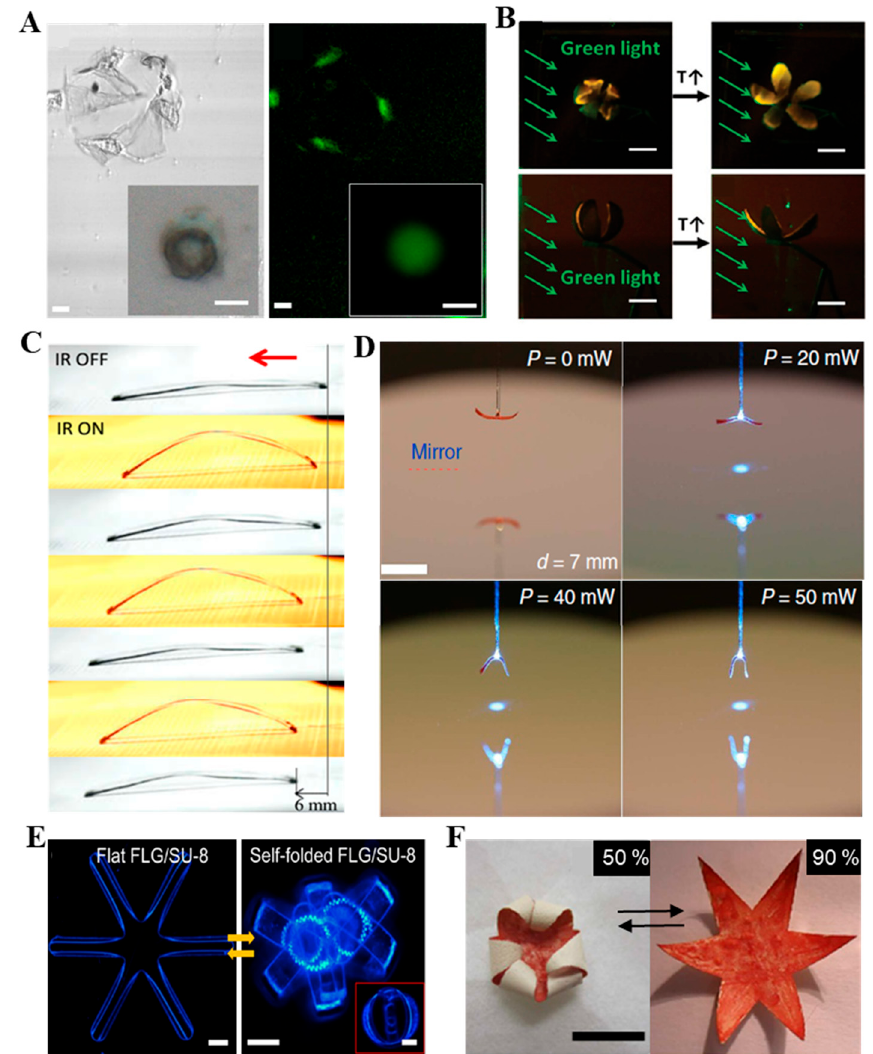
Figure 5. ( A ) Encapsulation of live cells within the functionalized flower-shaped thermally responsive graphene/poly N -isopropylacrylamide (PNIPAM) gripper. Reproduced with permission [63], adapted